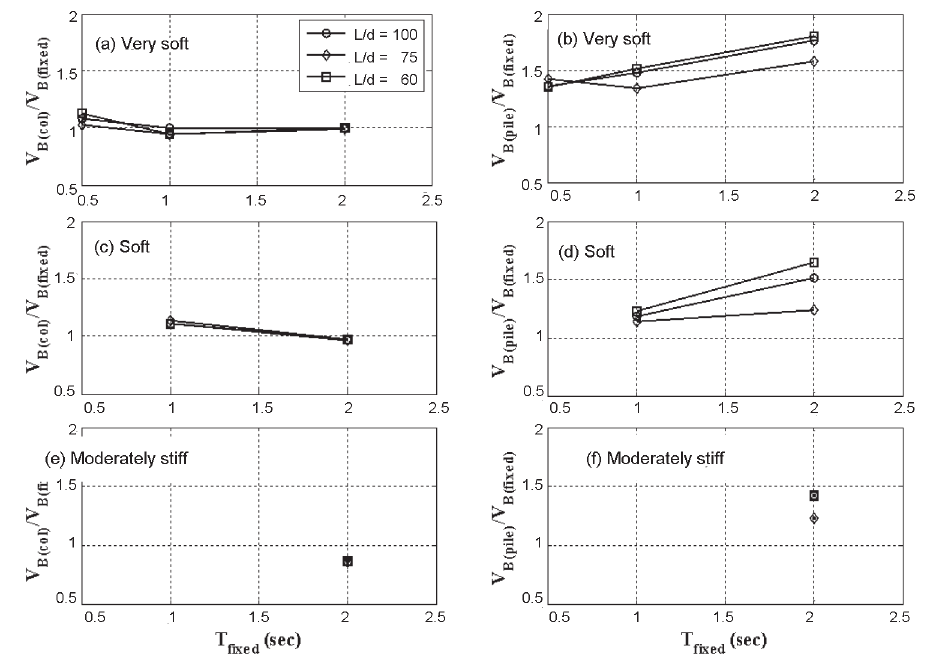
Fig. 7. Variations of normalised base shear for linear variation of soil modulus for different L/d ratios: a) V B(col) / V B(fixed) versus T fixed for very soft soil; b) V B(pile) / V B(fixed) versus T fixed for very soft soil; c) V B(col) / V B(fixed) versus T fixed for soft soil; d) V B(pile) / V B(fixed) versus T fixed for soft soil; e) V B(col) / V B(fixed) versus T fixed for moderately stiff soil; f) V B(pile) / V B(fixed) versus T fixed for moderately stiff